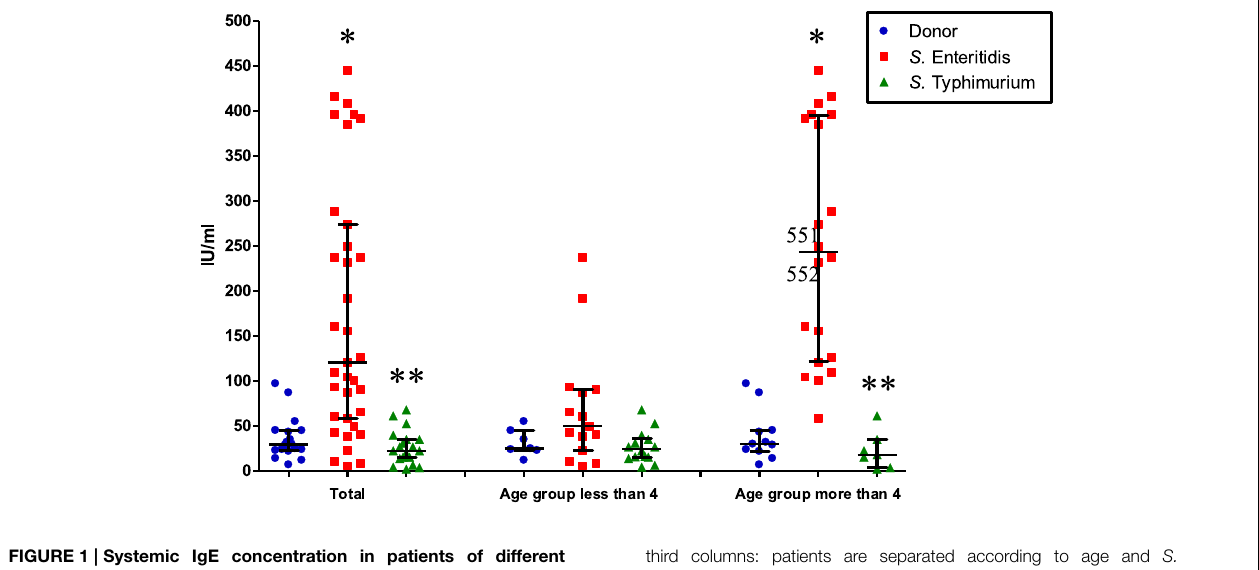
FIGURE 1 | Systemic IgE concentration in patients of different age and infected by different serotypes of S. enterica (median with interquartile range). Total: all patients infected by S . Typhimurium or S . Enteritidis, irrespective of age; control and either S . Enteritidis- or S . Typhimurium-infected. The second and